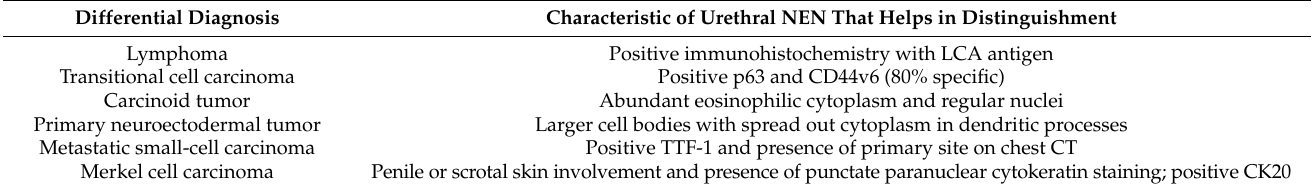
Table 10. Differential diagnosis of small-cell urethral NEC [124,125,128].